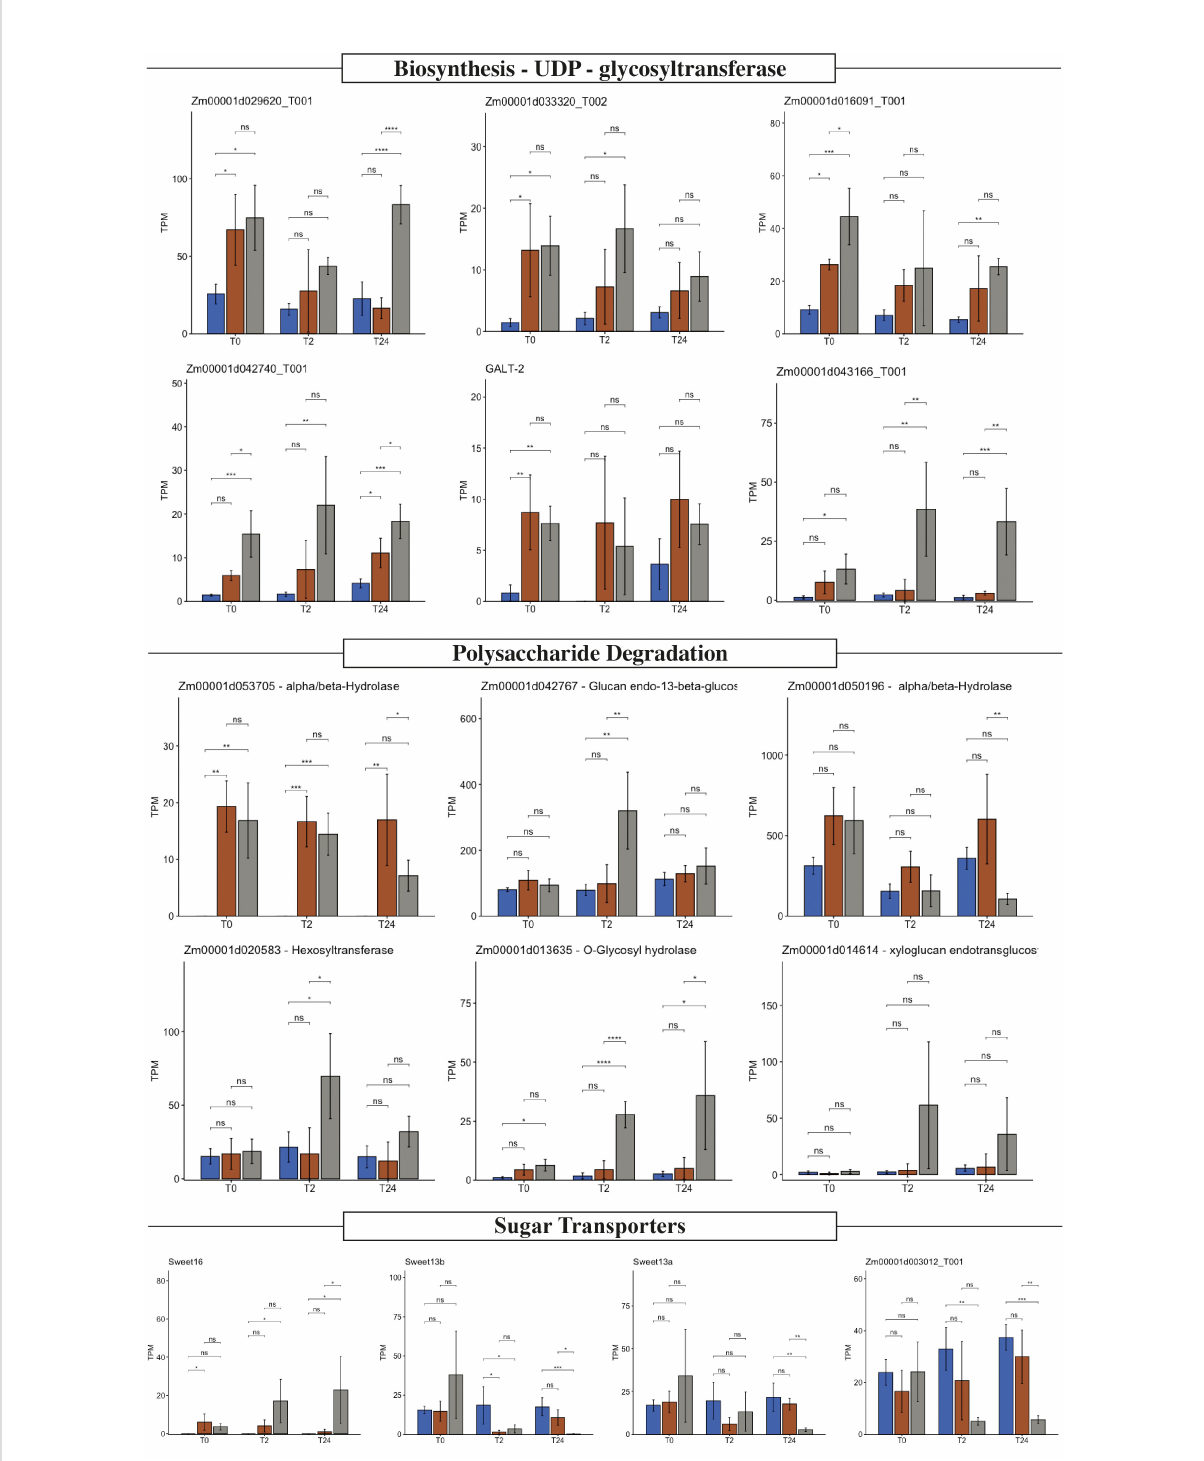
FIGURE 4 Polysaccharide biosynthesis, degradation, and sugar transport expression pro fi le. Expression value in transcripts per million (TPM) of six selected glycosyltransferases, six hydrolases, and four sugar transporters in Z. mays B73 (blue), Sierra Mixe (SM) stage 1 (orange), and Sierra Mixe stage 2 (gray) at zero (T0), two (T2), and twenty-four (T24) hours after adding water. Analysis of variance (ANOVA) was performed on TPM values and signi fi cance difference represents *p < 0.05; **p<0.01, ***p<0.001, ****p<0.0001. ns stands for non-signi fi